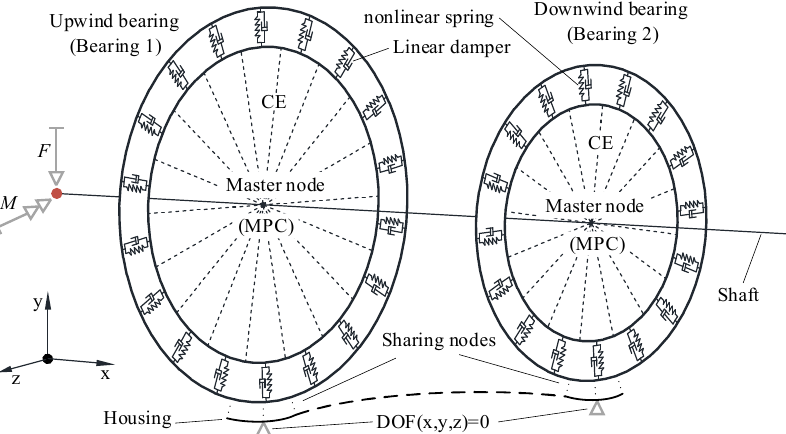
Figure 7. Coupling connection relationship of the shaft assembly.